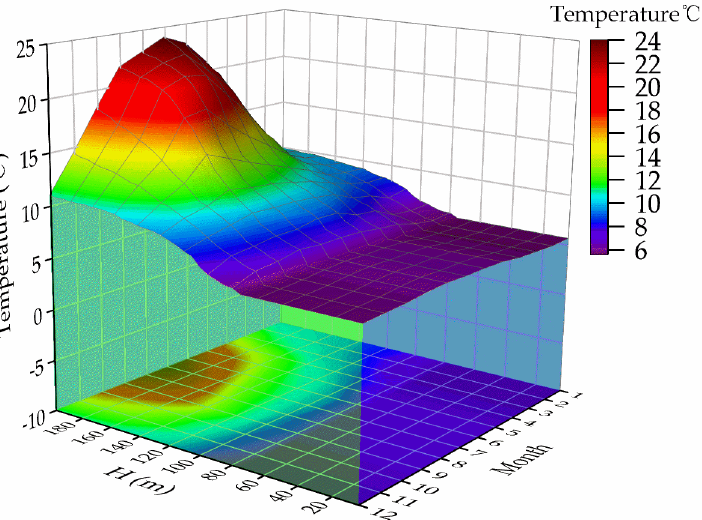
Figure 2. The temporal and spatial distribution of the measured water temperature of Xulong.